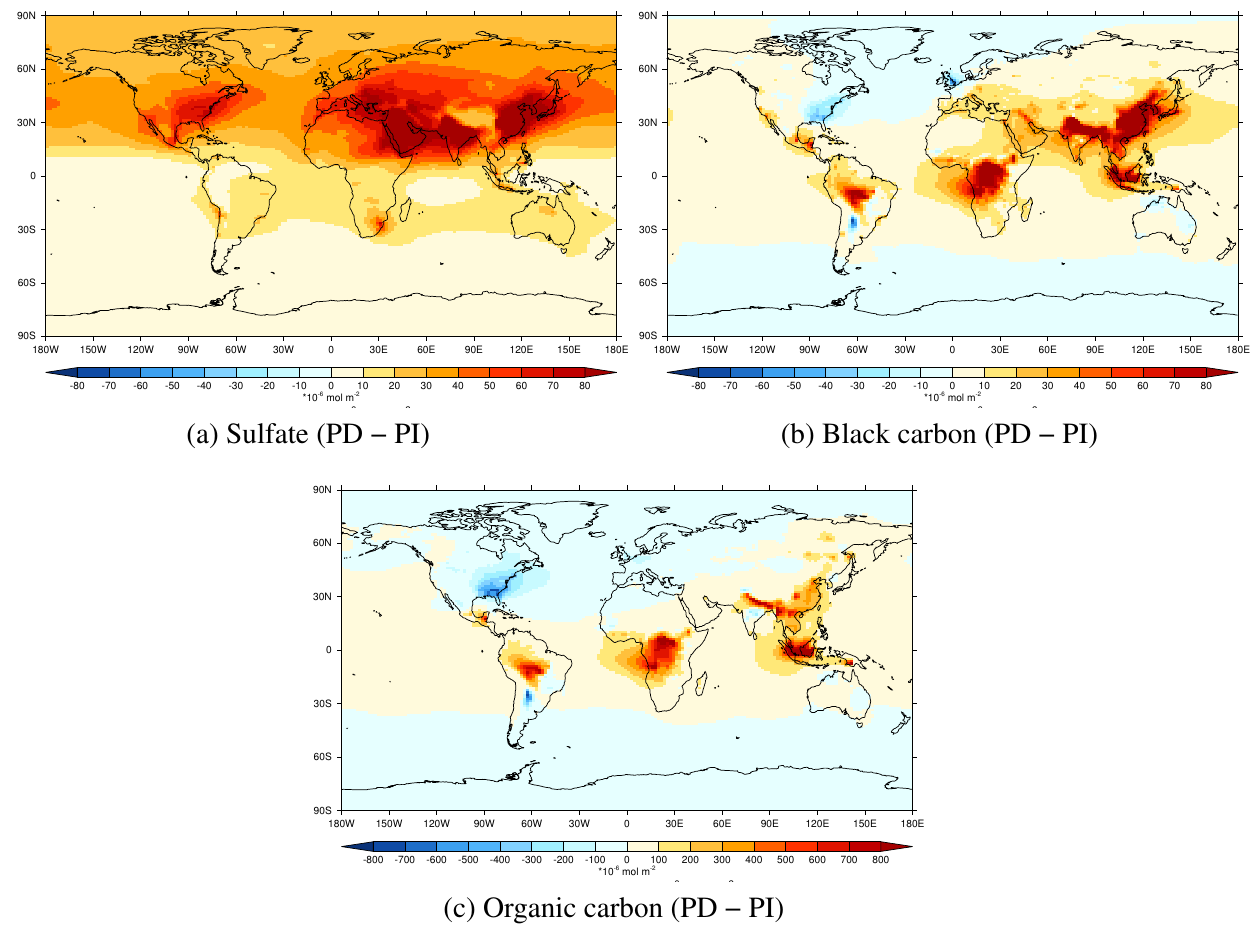
Figure 10. Change in annual mean aerosol burden by component: (a) sulfate (AWM = 23 . 06 × 10 − 6 molm − 2 ) , (b) black carbon (AWM = 8 . 77 × 10 − 6 molm − 2 ) , and (c) organic carbon (AWM = 31 . 26 × 10 − 6 molm − 2 ) . All results from pairs of runs of model sigw0.4 run with pre-industrial and present-day aerosol emissions; figures show absolute differences (PD − PI) between pairs of runs.